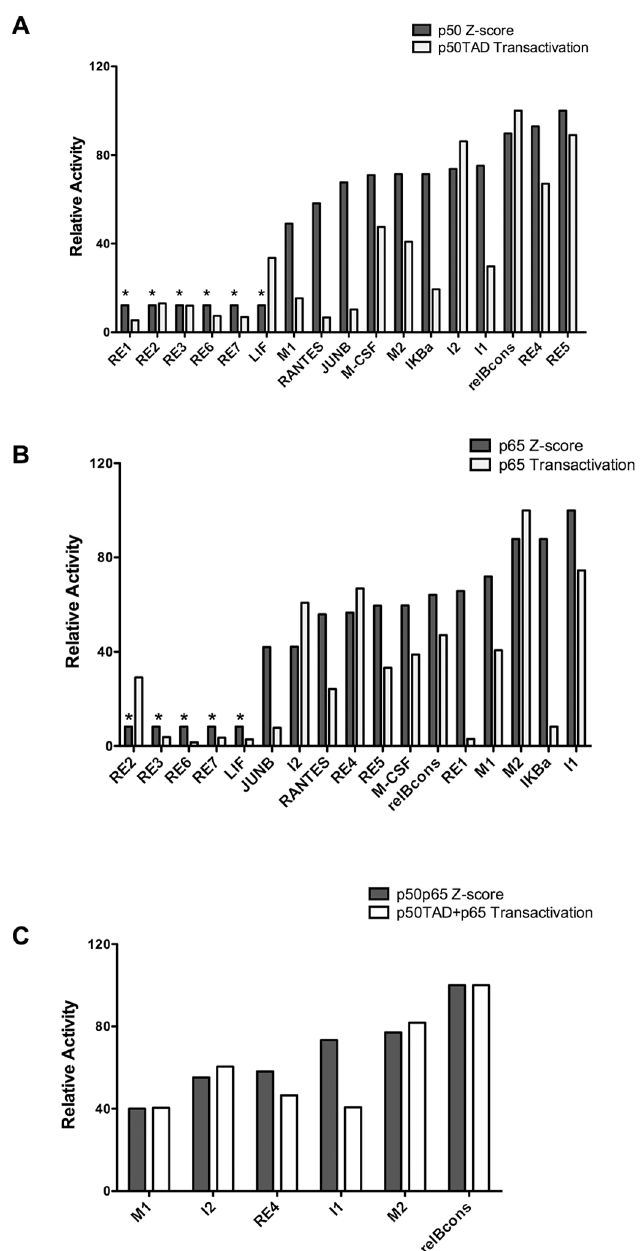
Fig 7. Comparison between predicted DNA binding affinity and yeast-based transactivation. A) , B) The relative binding affinities of p50 or p65 towards 17 κ B-REs were obtained from (http://thebrain.bwh. harvard.edu/nfkb) and compared with the relative transactivation potential measured in yeast at moderate levels of galactose induction. REs are ordered from left to right based on increasing Z-score for DNA binding affinity. The highest affinity RE (RE5 for p50 and I1 for p65) is set to 100. REs with Z-score lower than 4, considered equivalent to background, are labeled by * . C) Similarly, Z-scores of the p50-p65 heterodimers and transactivation potentials are compared for the 6 κ B-REs that were tested in the co-expression experiments in yeast.